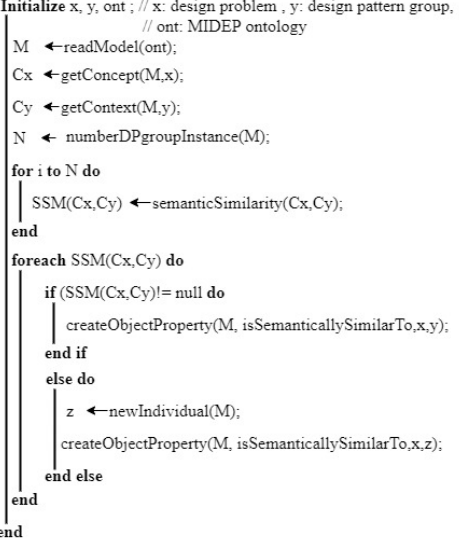
Figure 6. Semantic similarity check algorithm. Table 4. A rule example for matching design pattern groups.